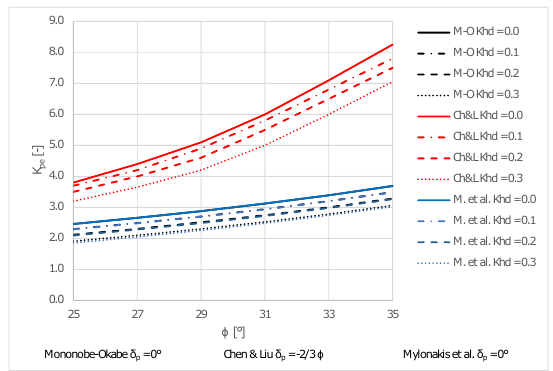
Figure 6. Comparison of methods for calculating the passive coefficient of seismic earth